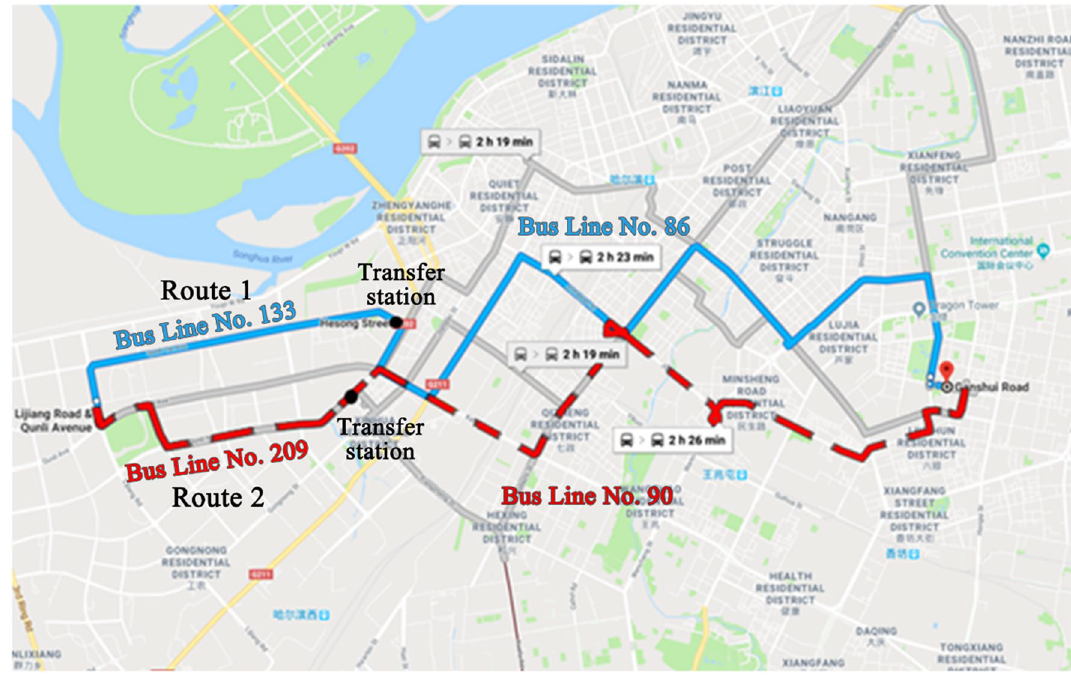
Fig. 14 Two routes from Qunli Road Stop to Ganshui Road